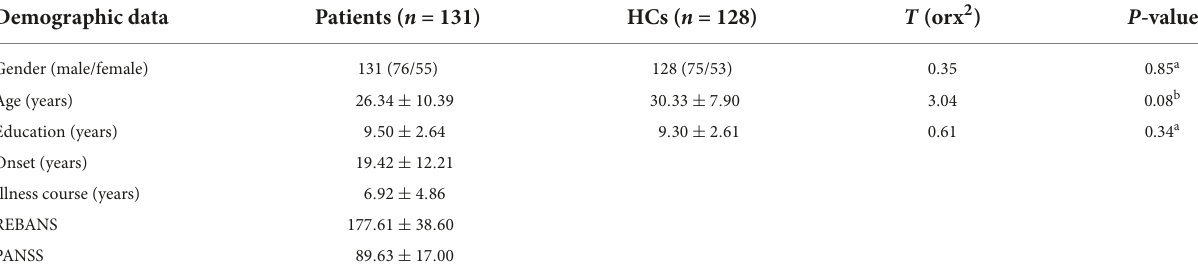
TABLE 1 Characteristics of the participants.